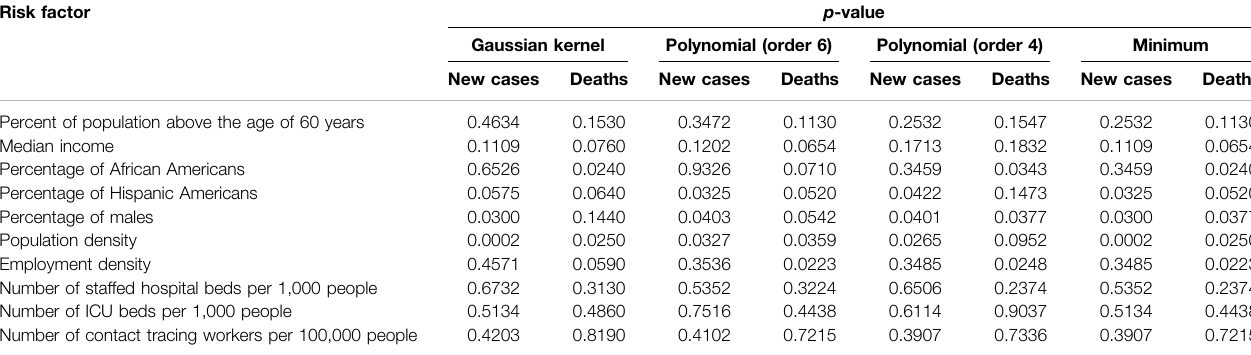
TABLE 1 | p -values for testing 10 scalar potential causes of the number of new cases and deaths of COVID-19 in the US. Risk